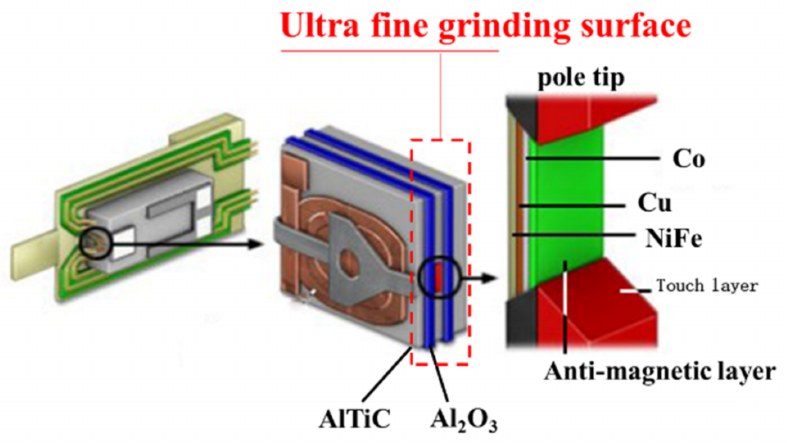
Figure 1. Illustration of an ultrafine grinding